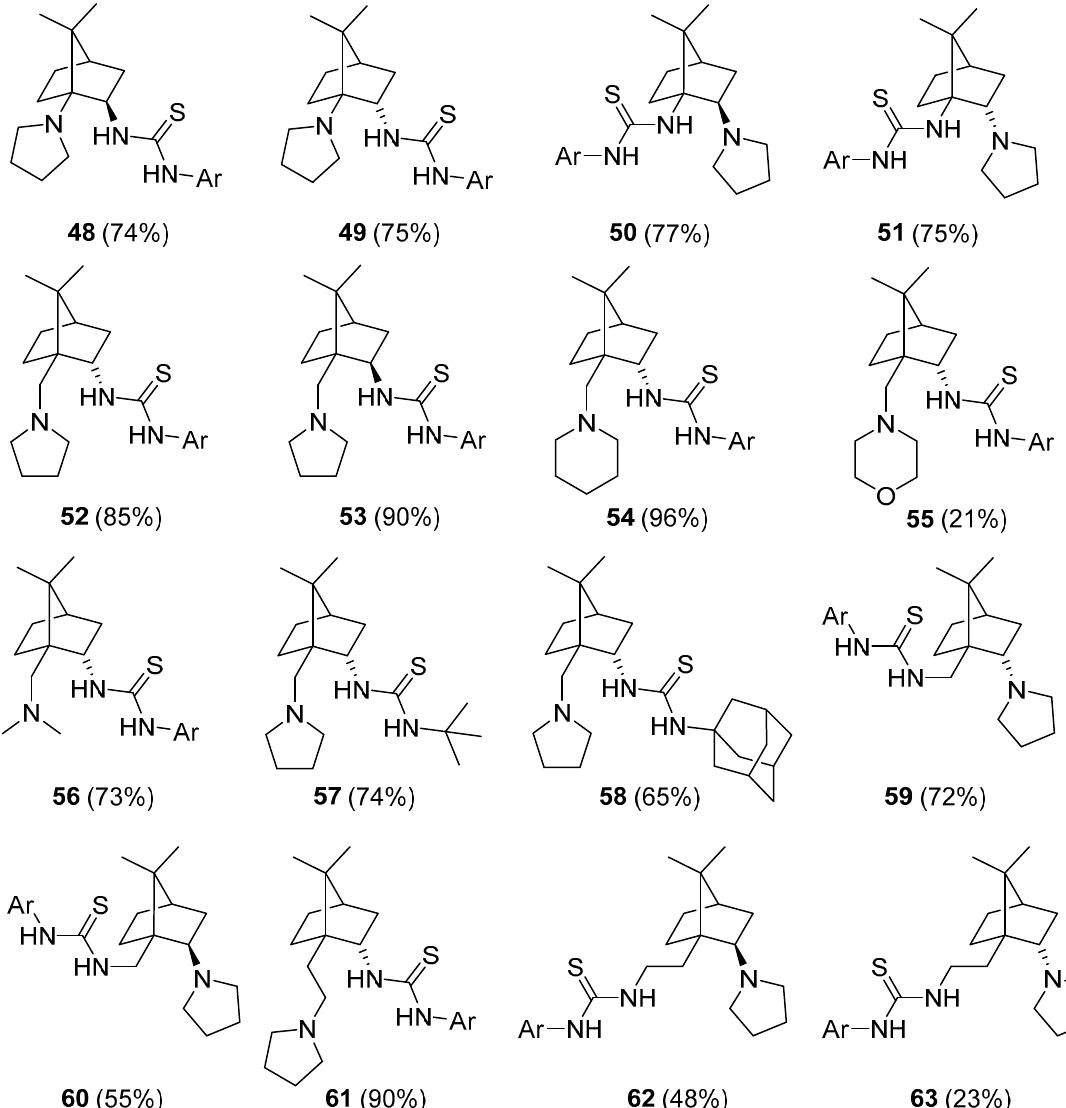
Figure 2. Thiourea derivatives 48 – 63 (Ar = 3,5-bis(trifluoromethyl)phenyl) prepared by treatment of respective primary amine with respective isothiocyanate in Et 2 O at r.t.